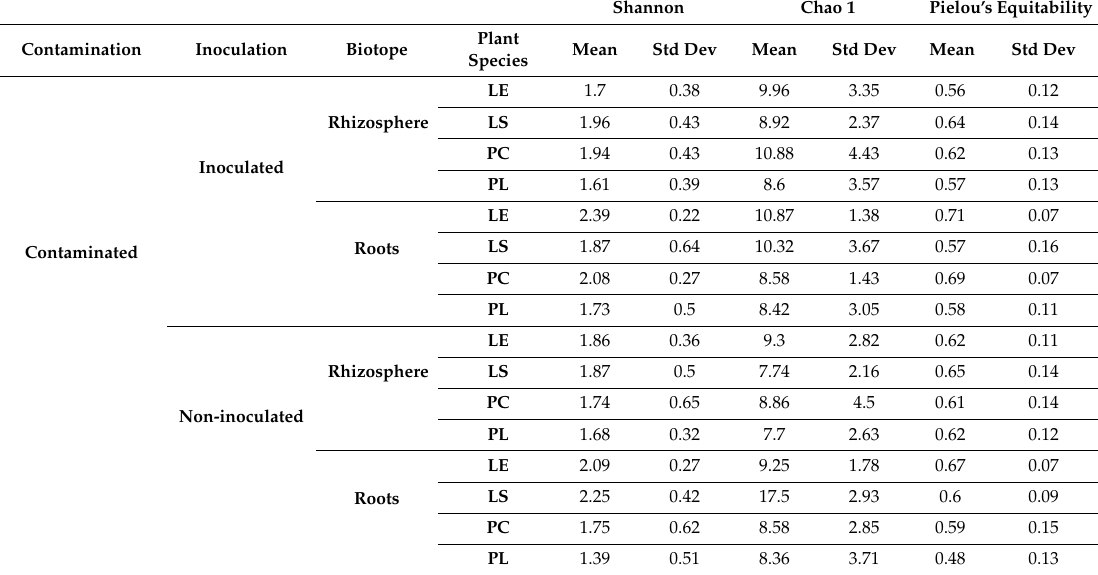
Table 1. Alpha diversity indices of AMF communities as calculated in the di ff erent treatments and